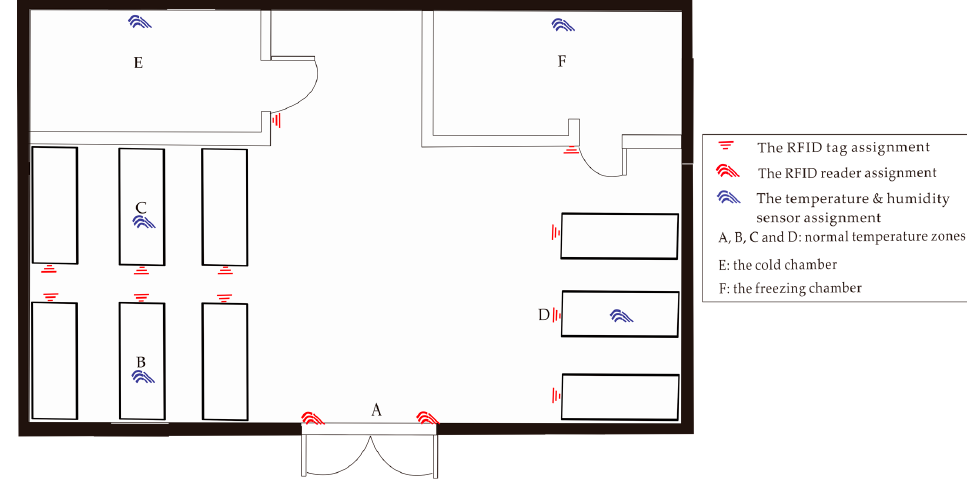
Figure 2. The layout of the storage with deployed sensors. Table 1. Typical events of a storage object.